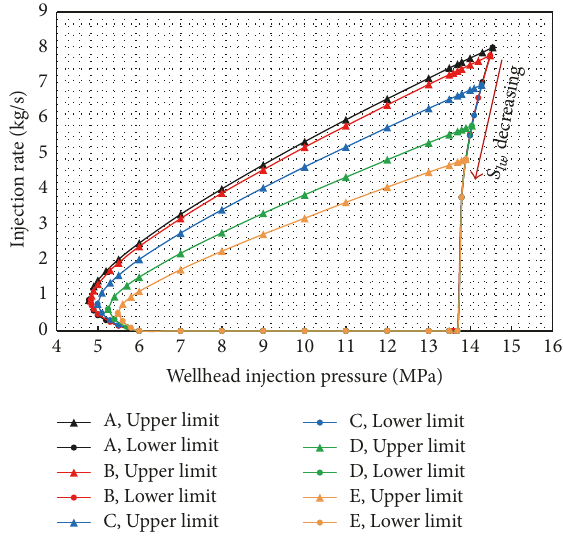
Figure 7: Relationship diagram between wellhead injection pres- sure and injection rate at different 𝑆 𝑙𝑤